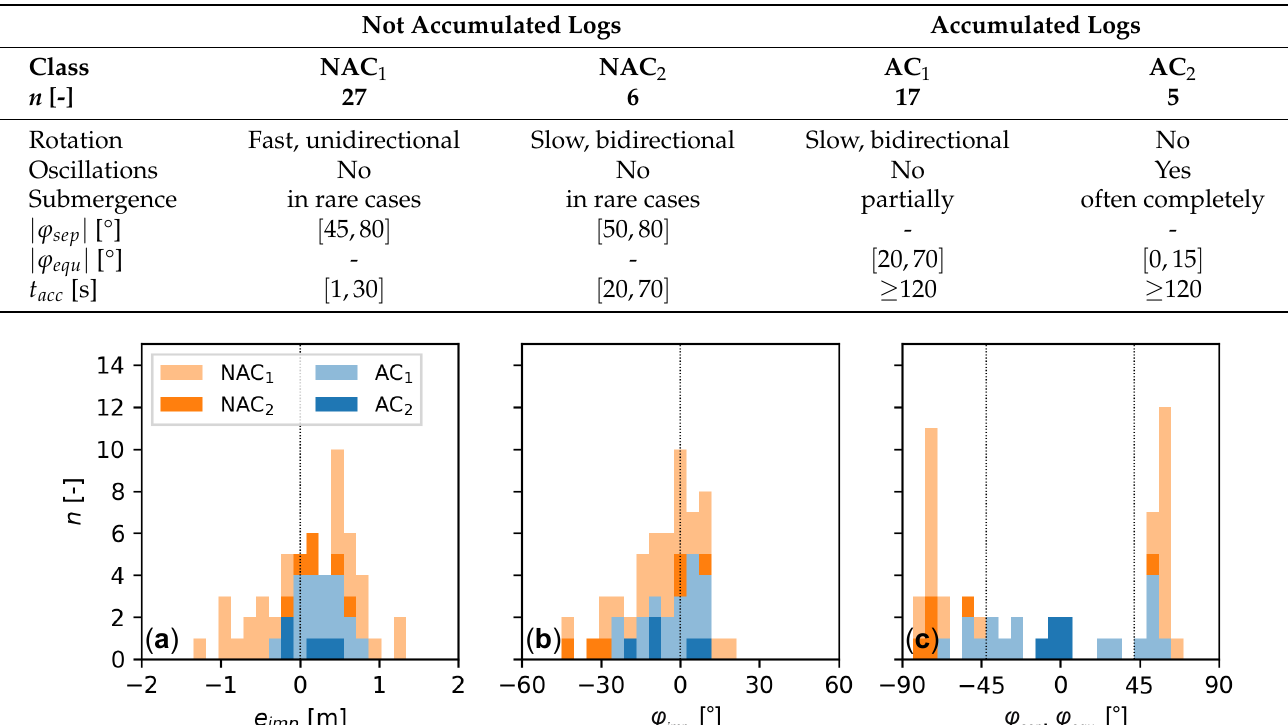
Figure 10. Histograms of ( a ) impact eccentricity e imp , ( b ) impact yaw ϕ imp , and ( c ) final yaws at separation point ϕ sep (NAC logs) or in equilibrium ϕ equ (AC logs); the dotted lines indicate the critical yaw ϕ cr = ± 42°.